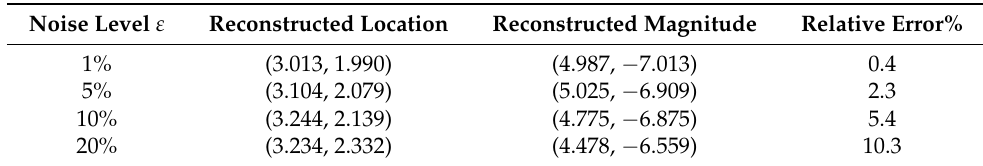
Table 8. Reconstruction of a point source with location (3, 2) and magnitude (5, − 7) for different noise levels test.